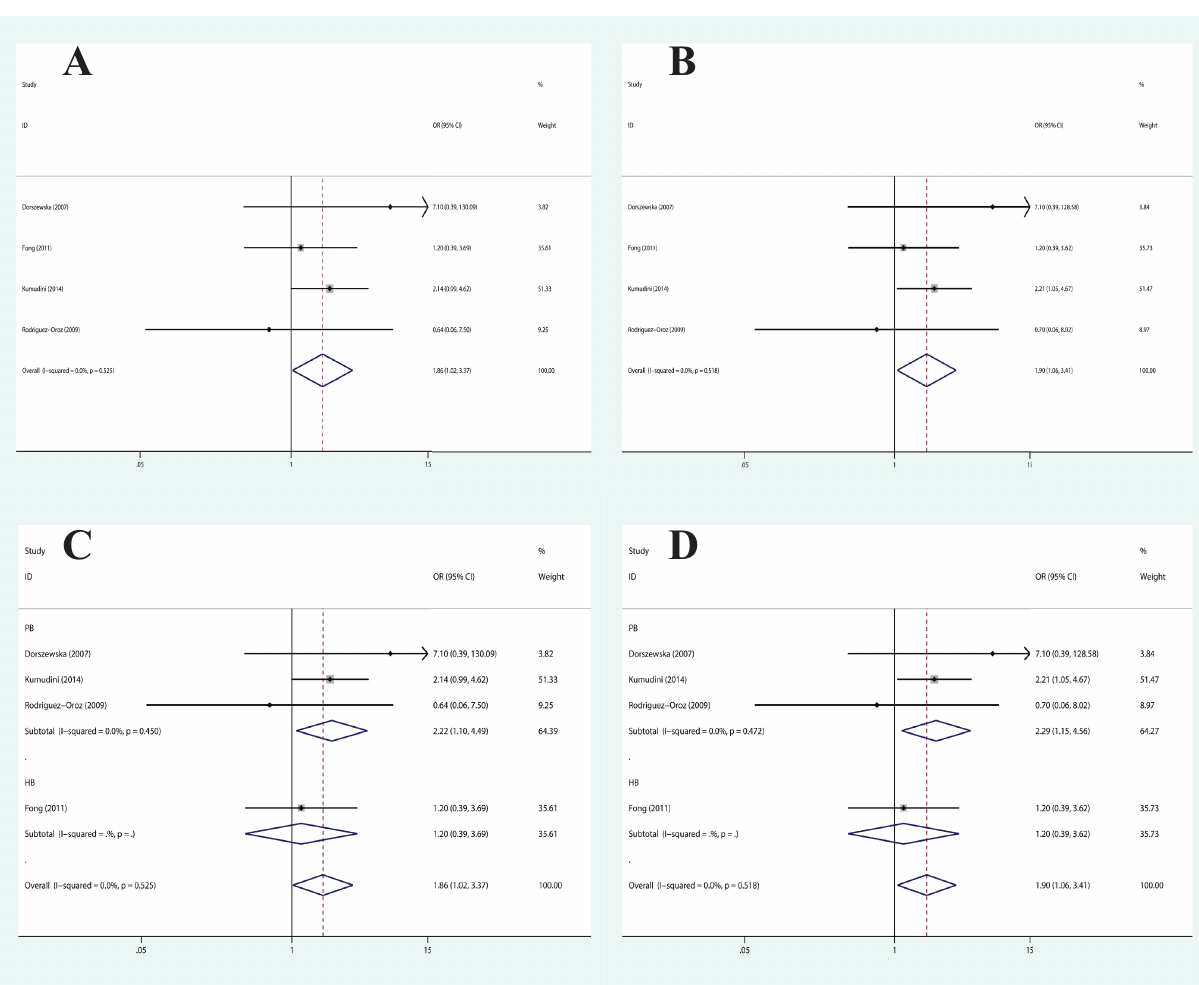
Figure 4: Forest plot of the association between MTHFR A2756G polymorphism and PD susceptibility: (A) co-dominant and (B) recessive genetic model in the overall populations; (C) co-dominant and (D) recessive genetic model, stratified by source of